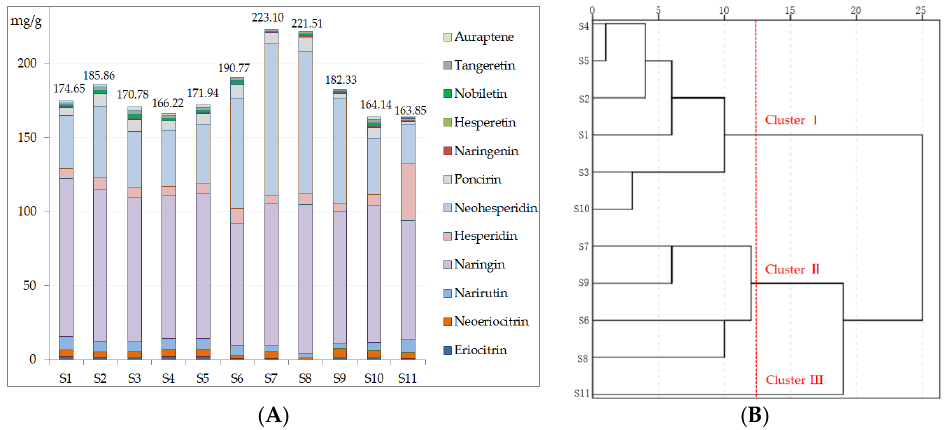
Figure 4. Contents of quantitative markers in Aurantii fructus from 11 different samples ( A ). Hierarchical clustering dendrogram of 11 samples of Aurantii fructus based on the quantitative analysis ( B ).